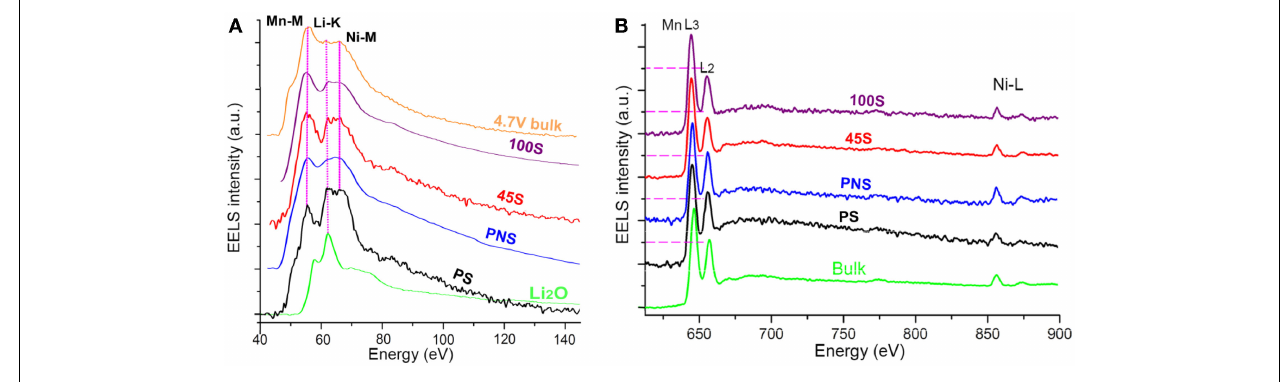
spectrum collected from Li 2 O sample; Bulk: spectrum collected from the bulk region of the PS. The degree of Li-K edge depression is 4.7V bulk > 100S > 45S (cid:25) PNS > PS. The order of Mn L3:L2 ratio is 100S > 45S > PNS (cid:25) PS (cid:25) Bulk (Yan et al., 2015). Reprinted with permission from Yan et al. (2015). Copyright 2015 American Chemical Society.